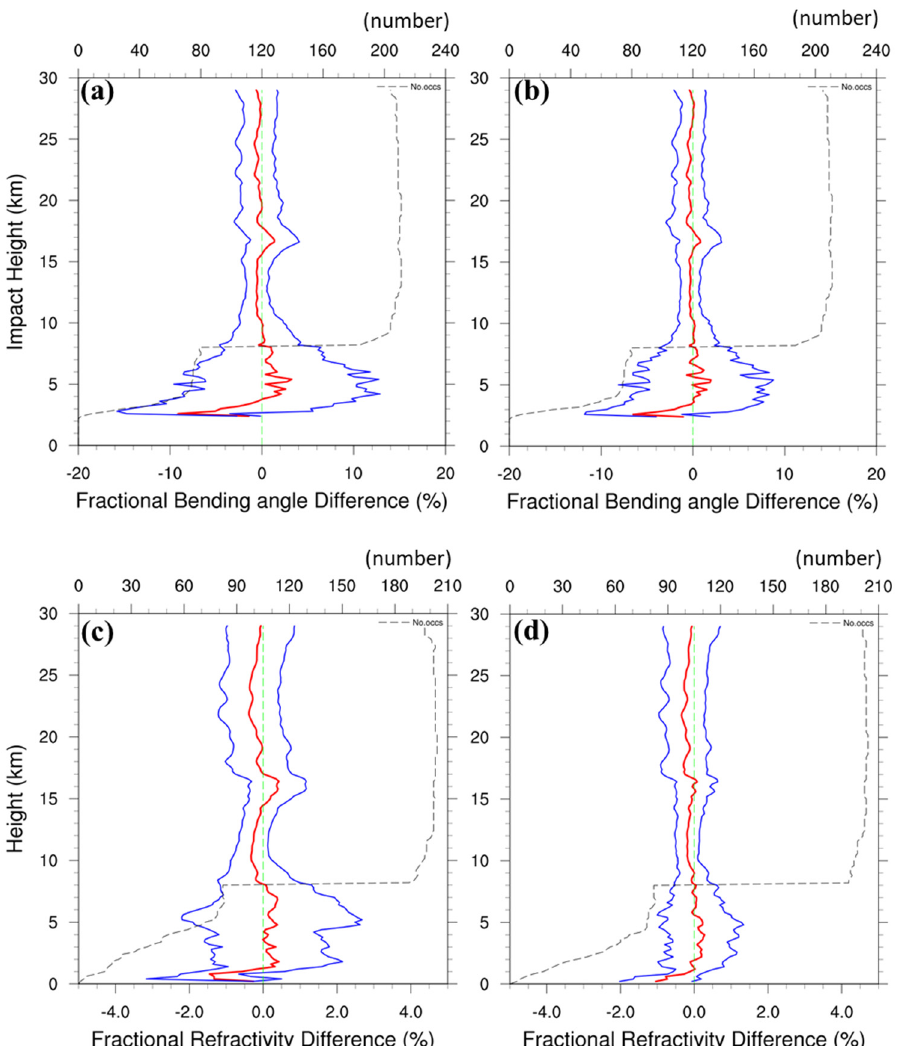
Figure 3. ( a ) The vertical profiles of mean fractional differences (red line) in bending angle (i.e., (O − B)/B in %) and their standard deviations (blue line) between the observation (O) and the first guess (B) at different impact heights in the local verification region during the data assimilation of two days for BND, and ( b ) as in ( a ) but for the observation (O) and the analysis (A), i.e., (O − A)/A in %. ( c , d ) as in ( a , b ), respectively, but the fractional differences for REF. The black dashed line indicates the number of all GPS RO soundings (see the top axis) used in the local verification region.